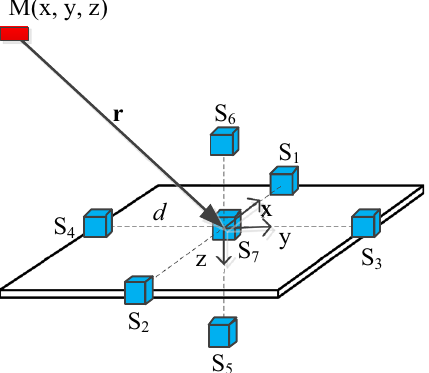
Figure 1. Schematic setup for simulation. The small cubes are scalar magnetometers.